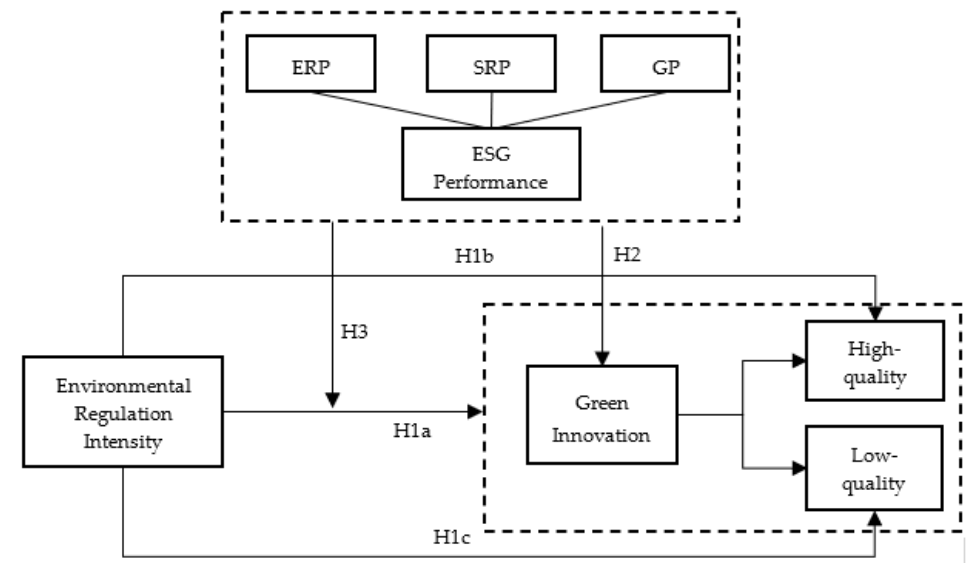
Figure 1. Theoretical model.